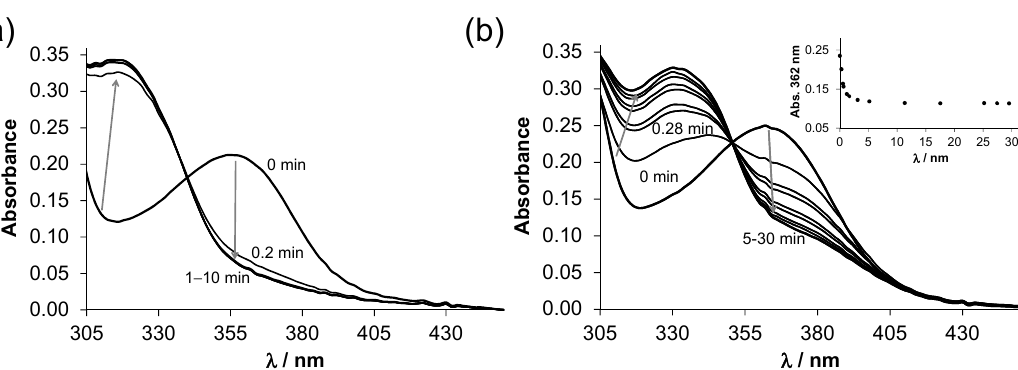
Figure 6. ( a ) Time-dependent changes of the UV–vis absorption spectra of ( a ) the Cu(II)—SISC (1:1); and ( b ) the Cu(II)—Pro-SISC-Me (1:1) systems in the presence of 10 equiv. GSH at pH 7.4 in 30% ( v / v ) DMSO/H 2 O under argon. Inserted figures in ( b ) show absorbance changes at 362 nm ( • ). ( c Cu(II) = c ligand = 25 µM, c GSH = 250 µM; pH = 7.4 (20 mM HEPES); T = 25 °C; I = 0.10 M (KCl); ℓ = 1 cm).